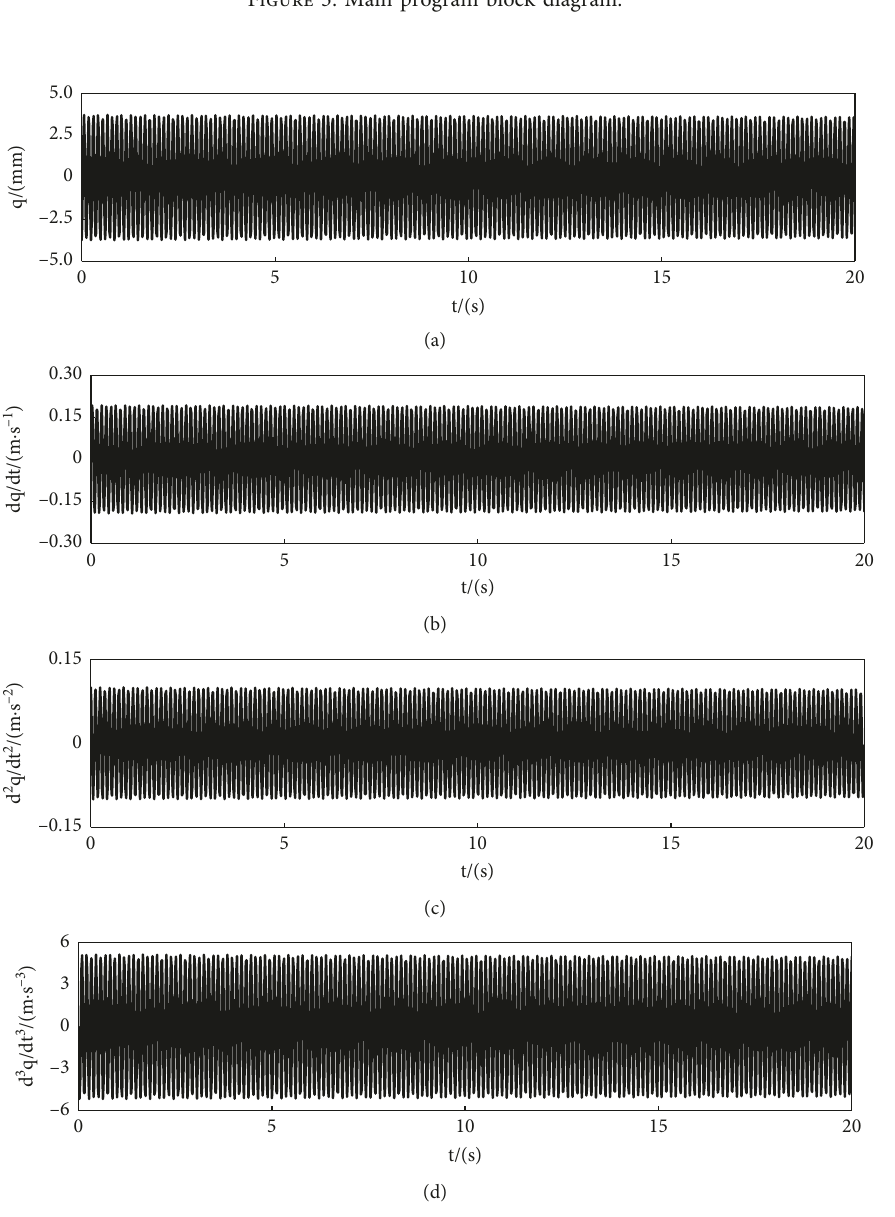
Figure 3: Main program block diagram.